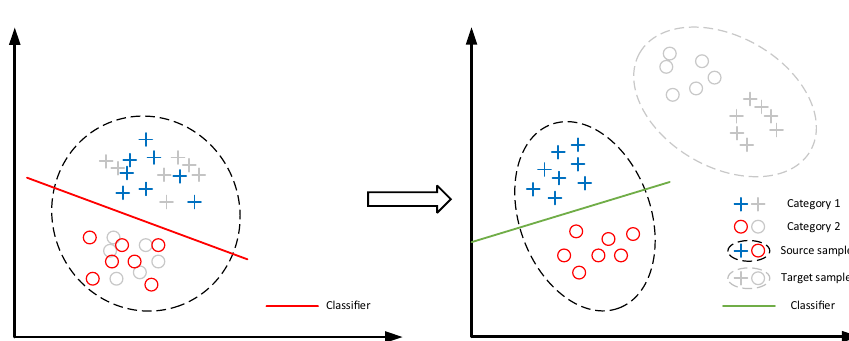
Fig. 2 Illustration of classifier and samples under two cases. a Distributions of the source and target domains keep the same. b Distributions of the source and target domain is quite